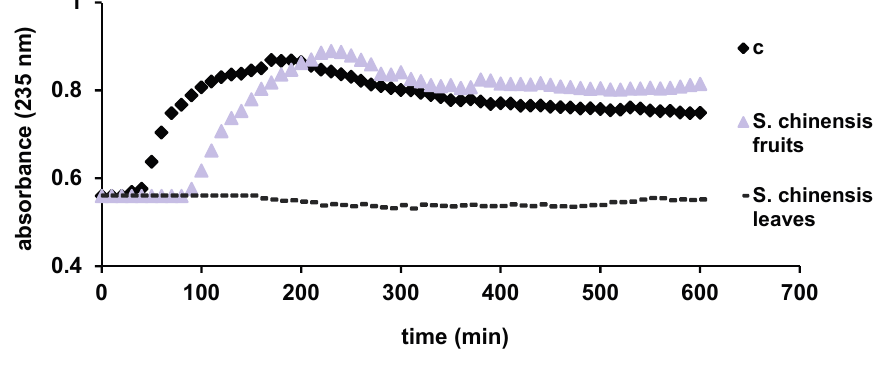
Figure 3. Liposome oxidation by cytochrome c , in the presence of the tested samples.